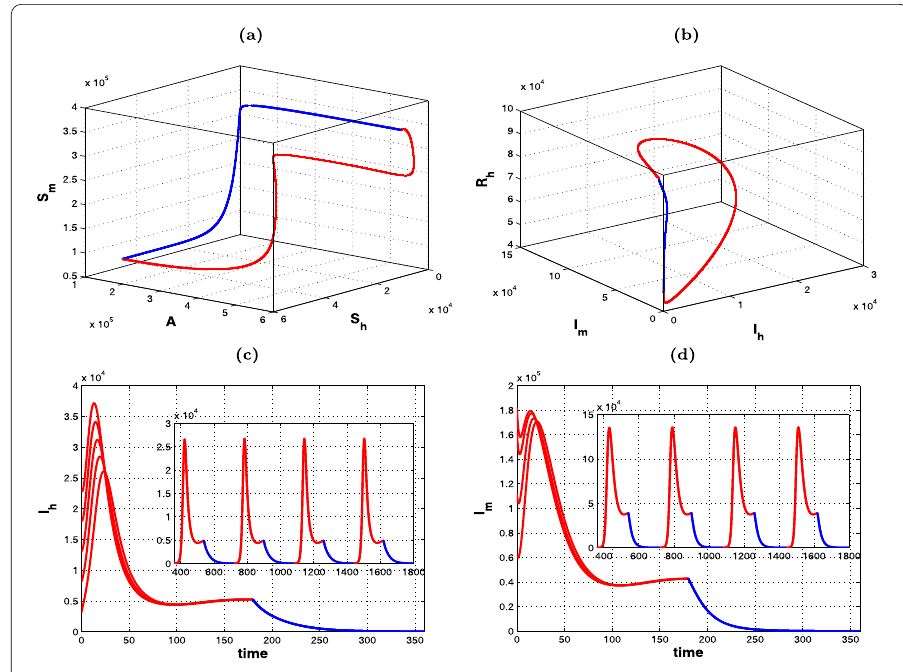
Figure 2 The uniform persistence of disease in model (1) and the existence of positive periodic solution of model (1) when R 0 > 1: ( a ) and ( b ) the existence of positive periodic solution; ( c ) and ( d ) the persistence and stability of this periodic solution